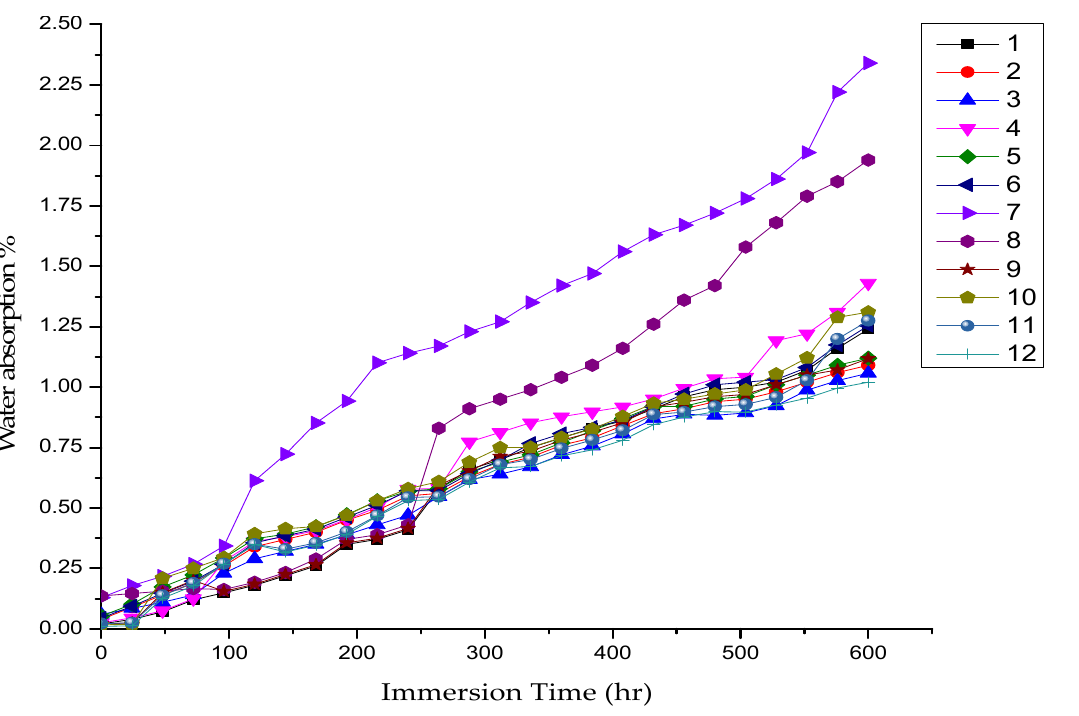
Figure 8. Water absorption capacity (%) as a function of wt.% and location of SiC particles.